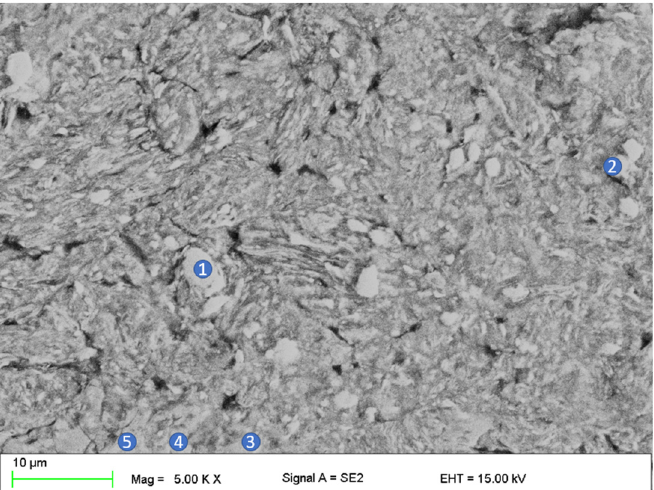
Figure 8. The SEM image featuring MgZn 2 phase regions in the powder sample. The numbers in the image refer to the EDS analysis results which are showcased in Table 4. Table 4. EDS results from the areas marked in Figure 8.